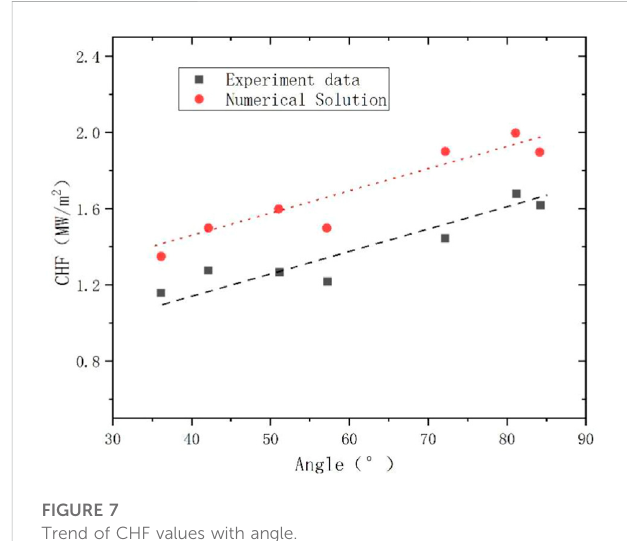
Trend of CHF values with